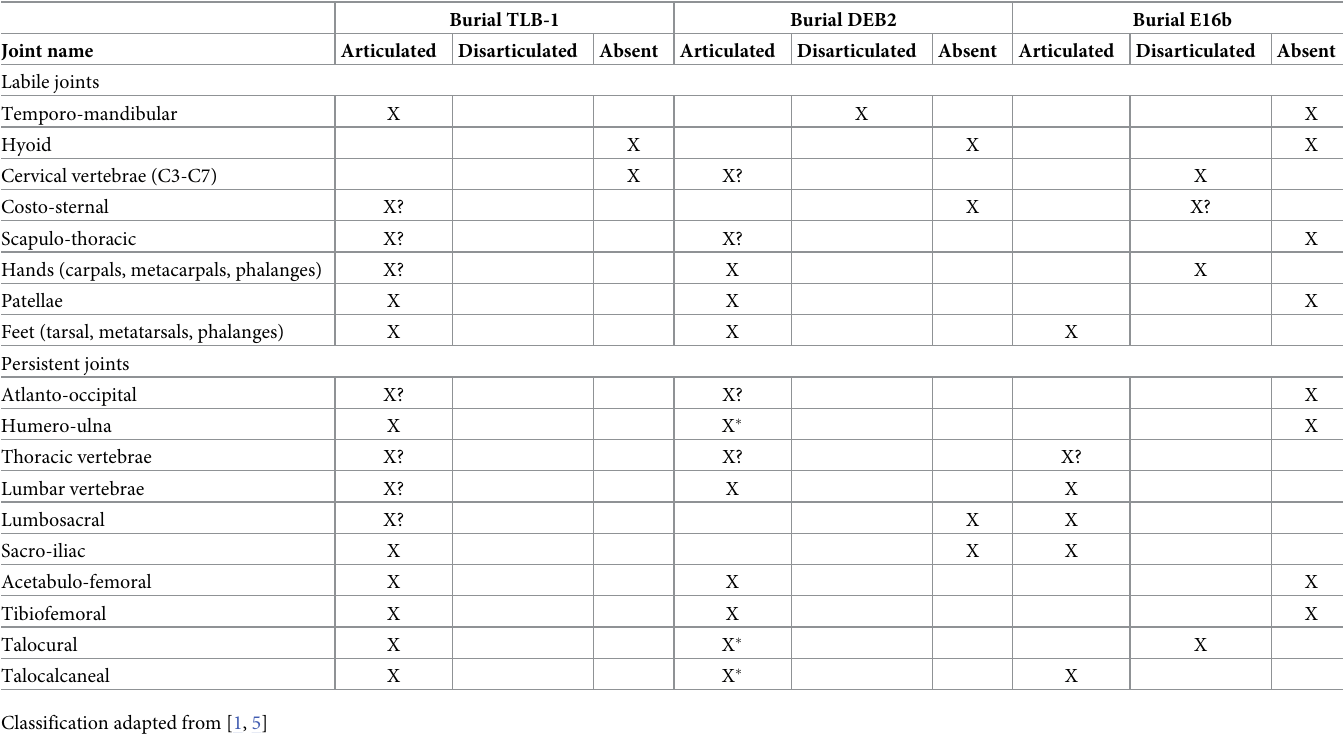
Table 2. Assessment of labile and persistent joints in the three individuals from Tron Bon